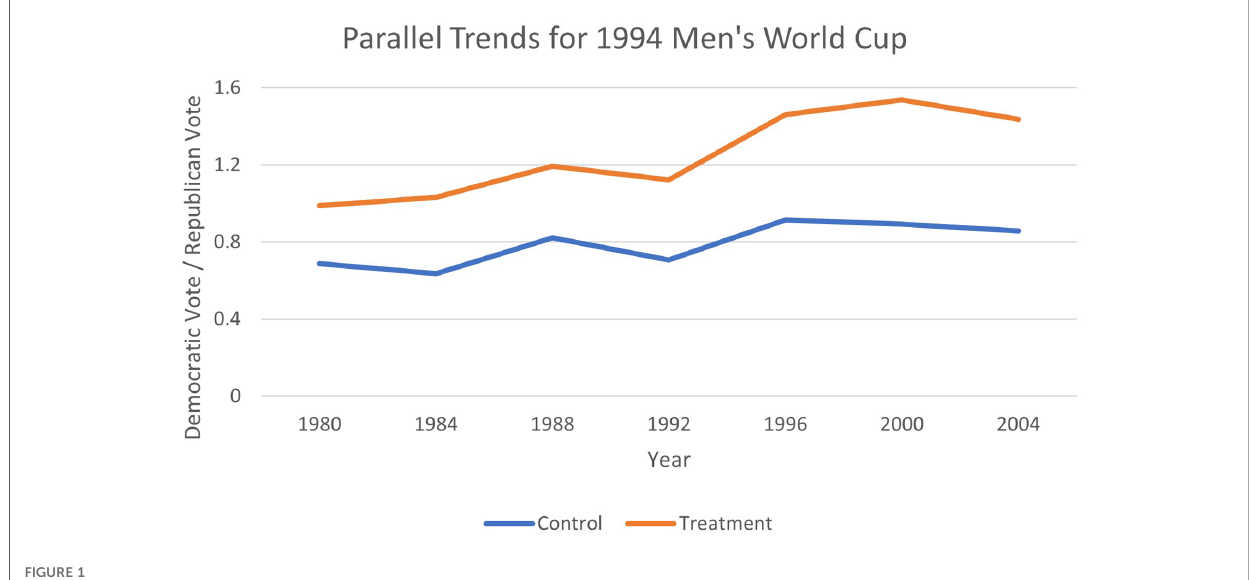
FIGURE 1 Testing parallel trends for 1994 Men ’ s World